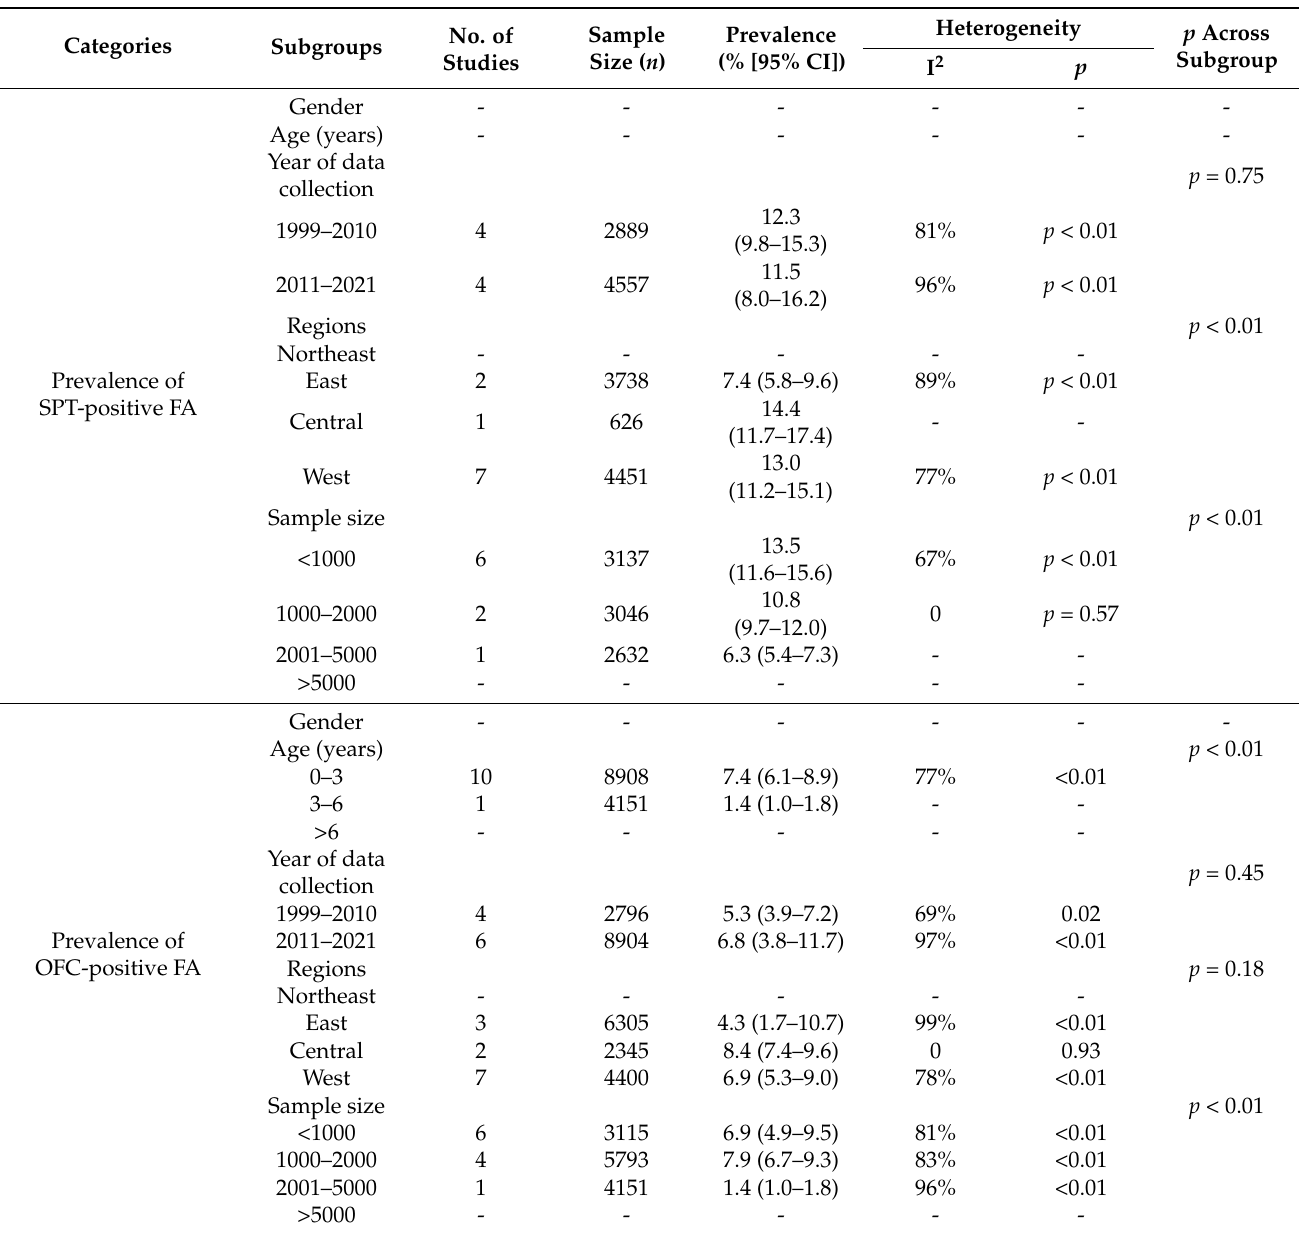
FA, food allergy; OFC, open food challenge; SPT, skin prick test; sIgE, specific IgE—not available. Prevalence of FA by regions. Subgroup analyses were performed according to four economic regions of China (northeast, east, central, and west). The results showed that the prevalence of FA varied by region, with a higher prevalence in West China ((12.1% (95% CI: 9.5–15.4%) for self-reported FA, 10.0% (95% CI: 6.1–16.0%) for self-reported